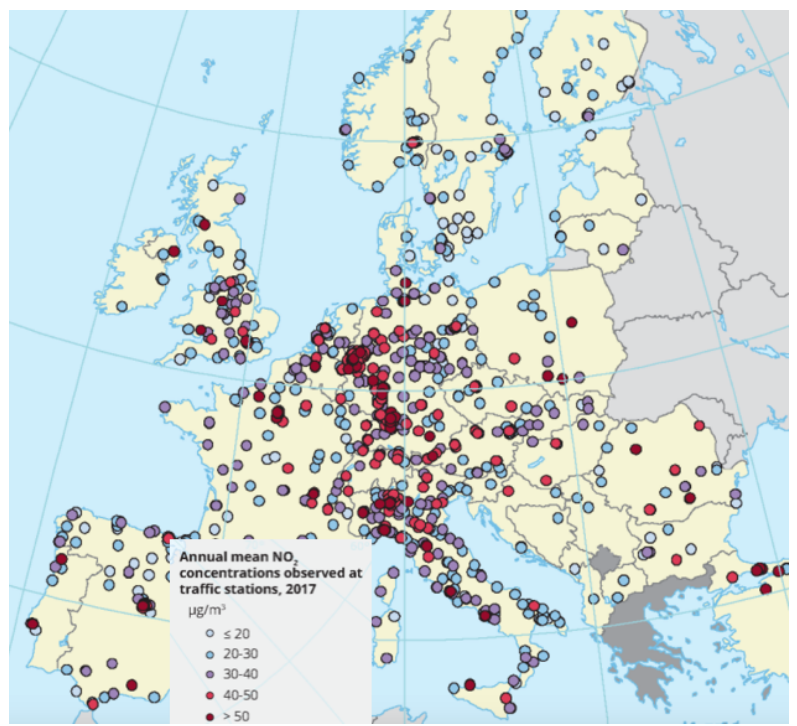
Figure 1. Map of locations with NO 2 emissions exceeded over the annual mean